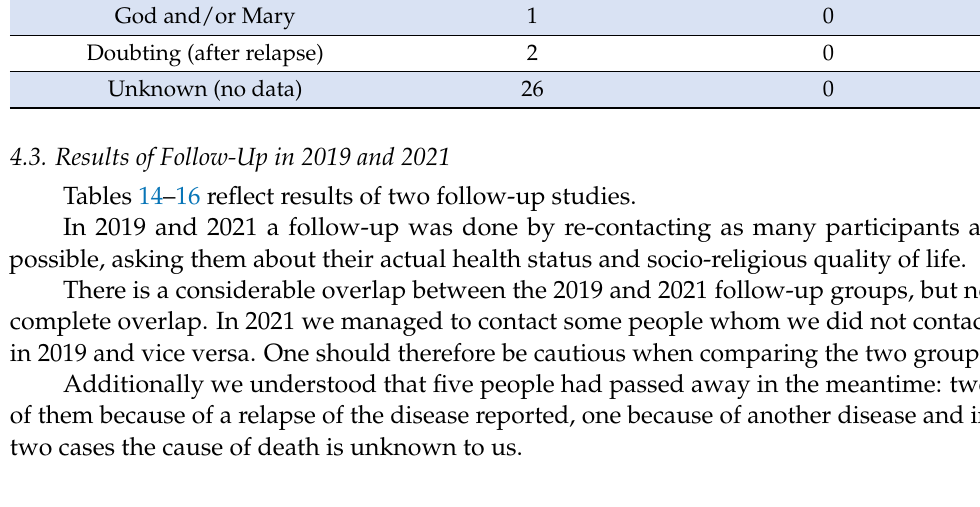
Table 14. Health outcome and socio-religious quality of life (QOL). Subject Investigated